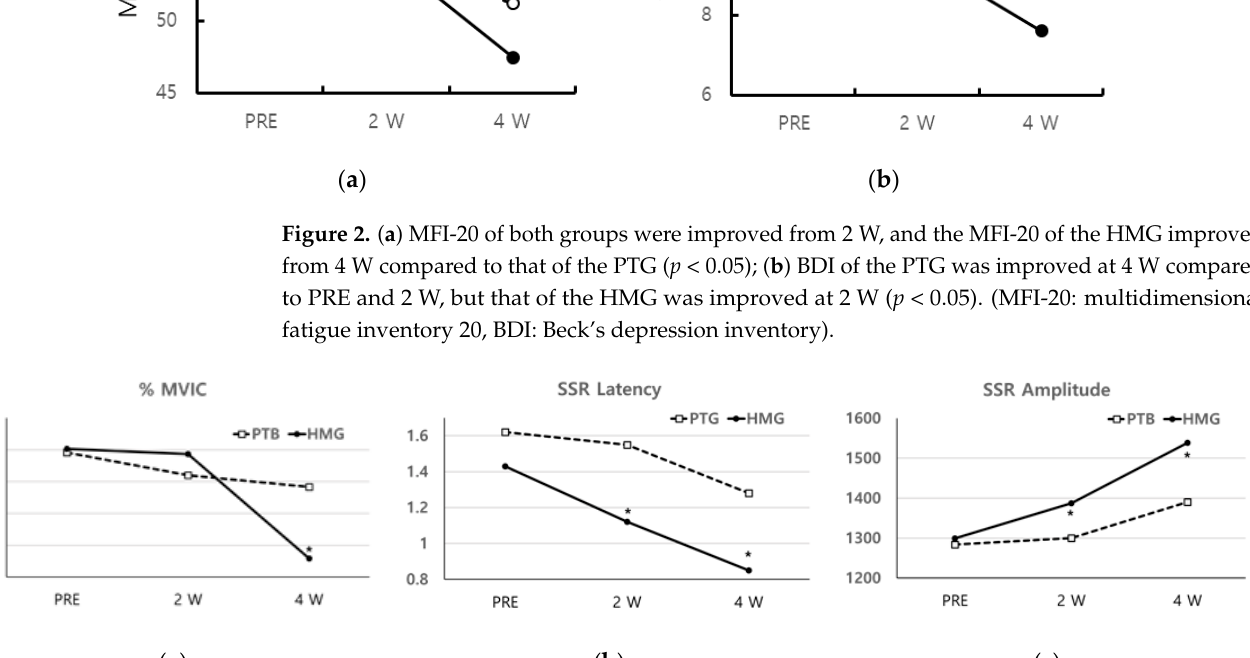
Figure 2. ( a ) MFI-20 of both groups were improved from 2 W, and the MFI-20 of the HMG improved from 4 W compared to that of the PTG ( p < 0.05); ( b ) BDI of the PTG was improved at 4 W compared to PRE and 2 W, but that of the HMG was improved at 2 W ( p < 0.05). (MFI-20: multidimensional fatigue inventory 20, BDI: Beck’s depression inventory).